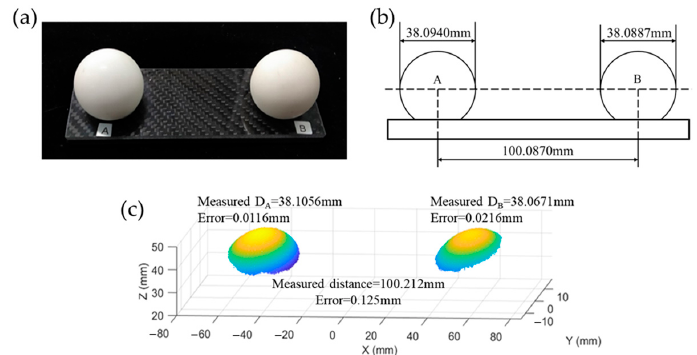
Figure 9. Reconstruction results of the standard ball plate: ( a ) physical map, ( b ) schematic diagram of size, and ( c ) 3D measurement result.